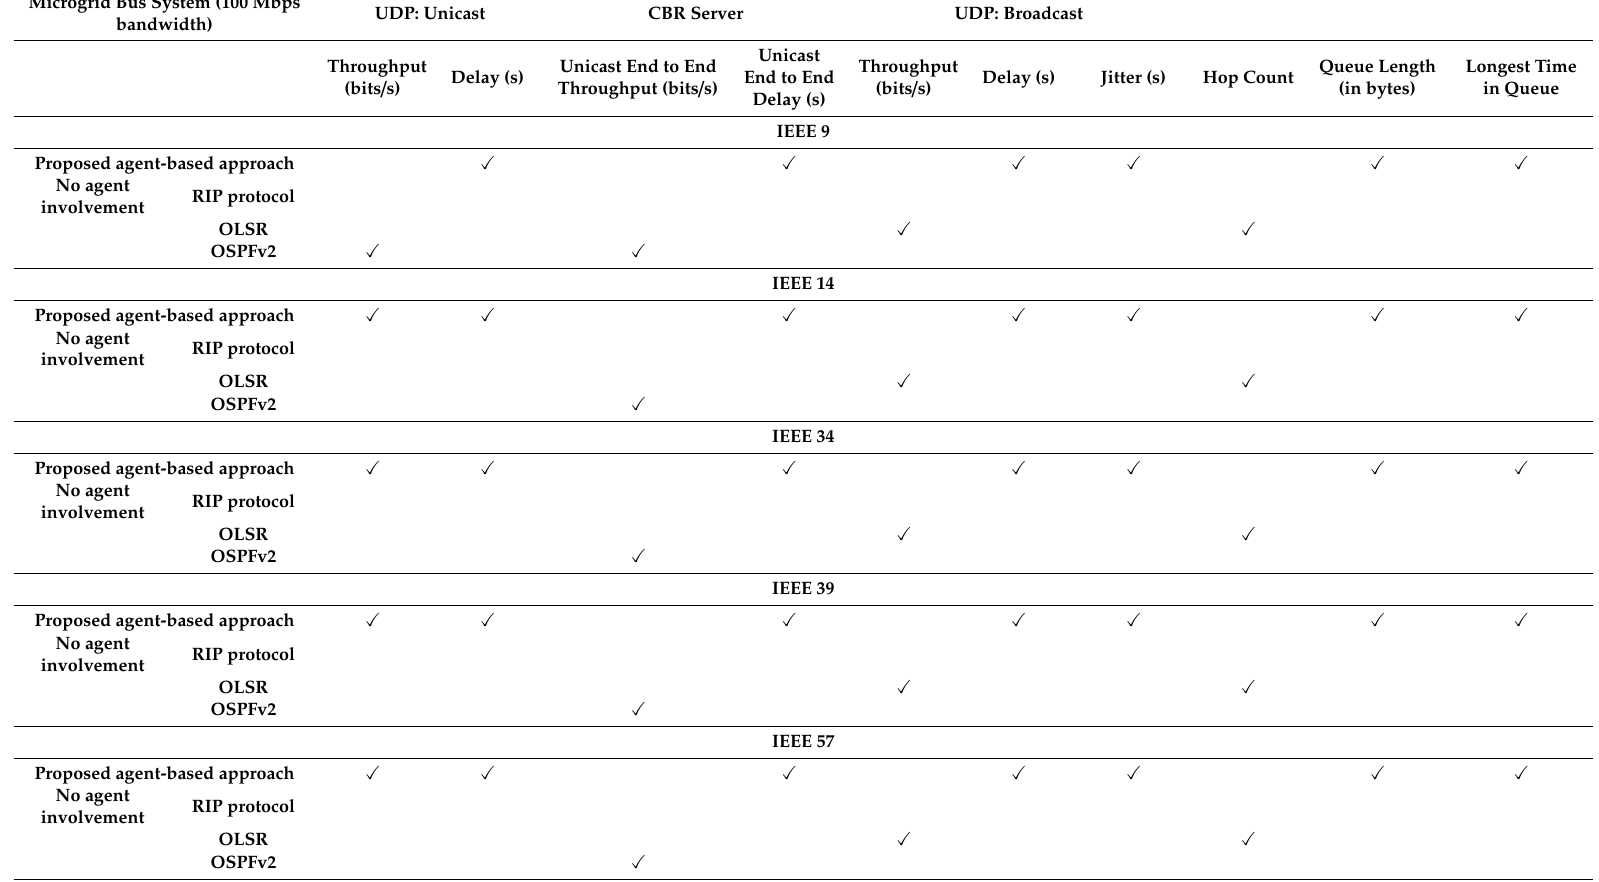
Table 2. Comparative analysis of performance shown in Table